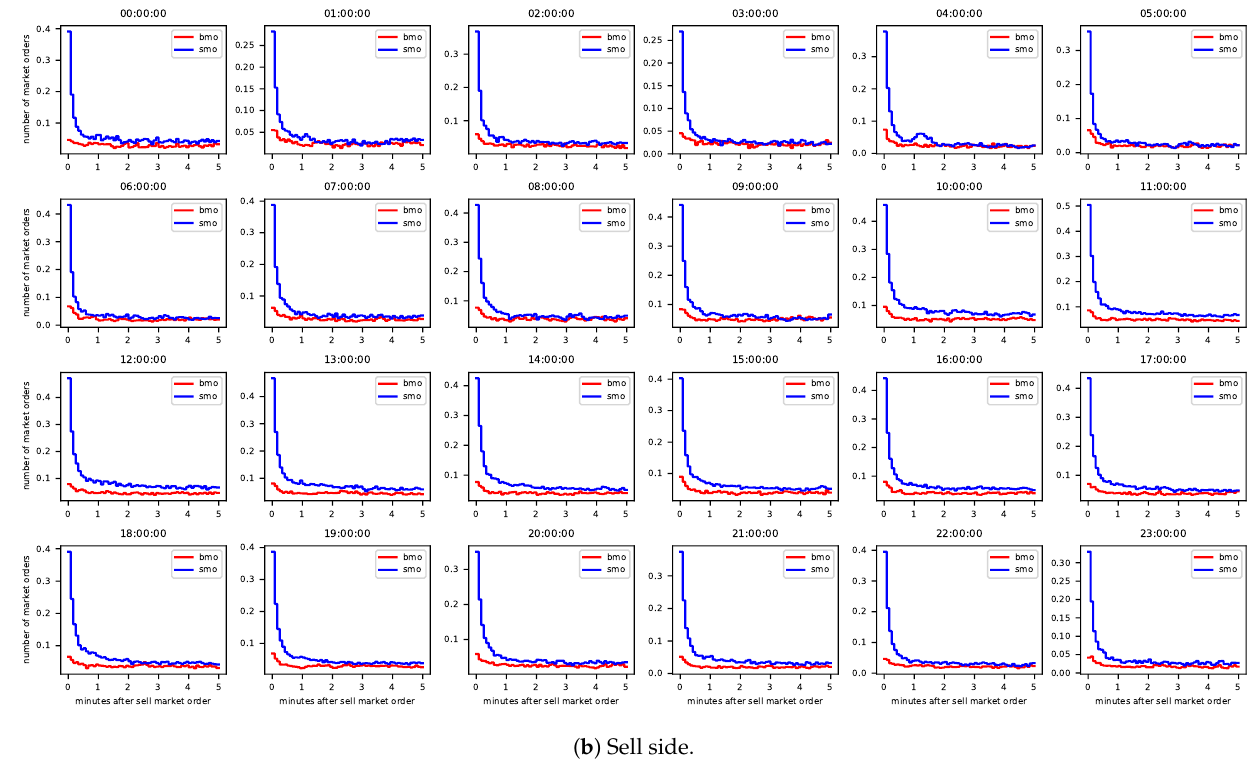
Figure 2. Mean number of buy and sell market orders in time intervals of 5 s after the arrival of a buy market order ( left ) and after the arrival of a sell market order ( right ). Data: All contracts with delivery start at 13:00:00 UTC in